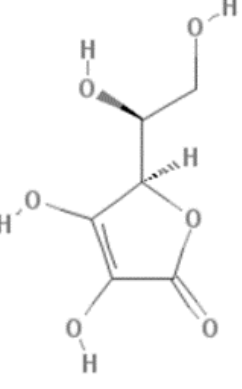
Figure 1. Structure of ascorbic acid .